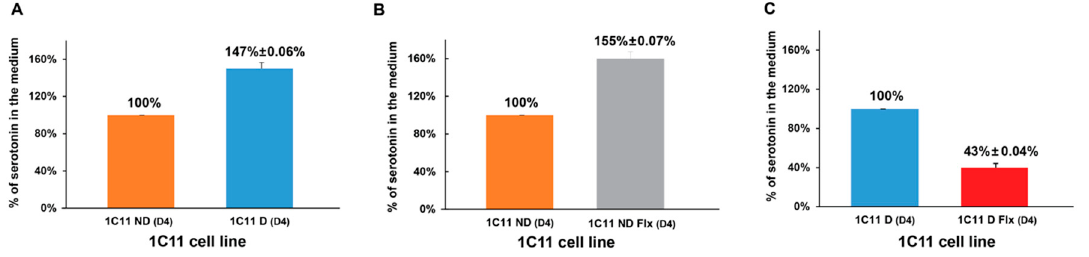
Figure 6. Dosage of serotonin in 1C11 cells in vitro. ( A ): Serotonin is higher when 1C11 cells are di ff erentiated (D4; 147% ± 0.06%) contrary to not di ff erentiated cells (D4; 100%). ( B ): Fluoxetine increased serotonin secretion of about 155% ± 0.07% in not-di ff erentiated cells and decreased it by about 43% ± 0.04% ( C ). Data from 3 di ff erent independent cultured 1C11 cell lines for each condition (1C11ND, 1C11D, 1C11NDFlx and 1C11DFlx). An analysis by an unpaired Student’s t -test is